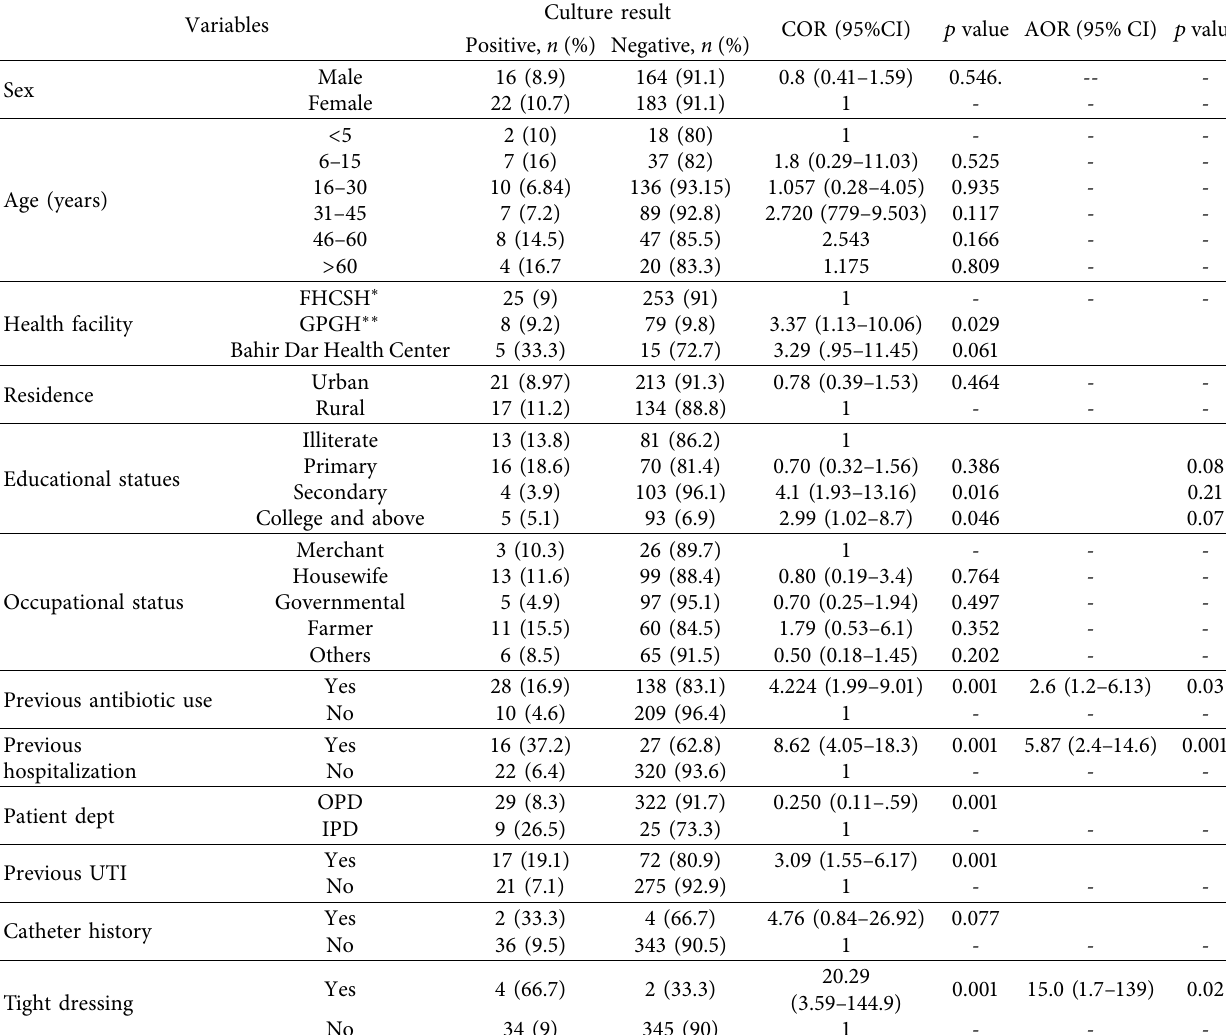
Table 5: Predictors of urinary tract infections in UTI-suspected patients who attended Bahir Dar City health institutions, Bahir Dar, Northwest Ethiopia,